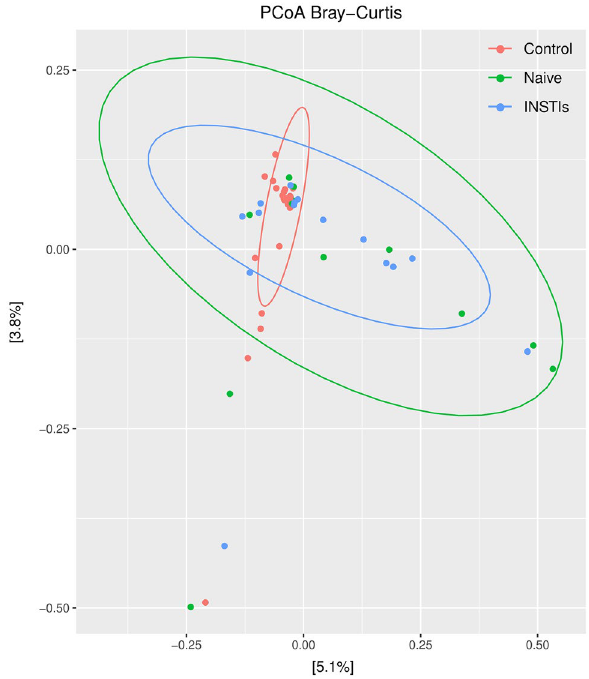
Figure 3. PCoA from phages in faecal samples from the studied population [accounting for 8.9% of the total variation (Component 1 = 5.1% and Component 2 = 3.8%)]. Results are plotted according to the first two principal components. Each circle represents a sample: red circles represent the uninfected volunteers, green circles represent the naive group, and blue circles represent the INSTIs-treated group. The clustering of samples is represented by their respective 95% confidence interval ellipse. padj < 0.01 naive vs. control and padj < 0.05 INSTIs vs . control. INSTIs (integrase strand transfer inhibitors-based treatment).